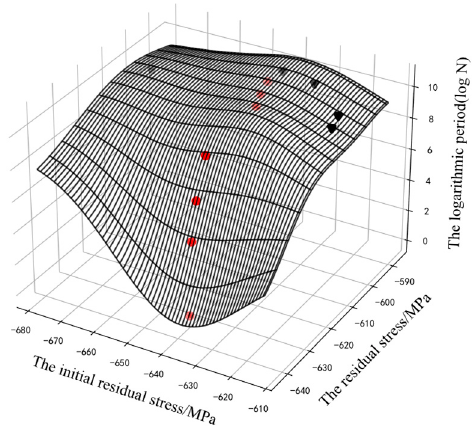
Figure 6. The assessment results of the GP: different line styles represent the fatigue relaxation process of different specimens. The triangle marks represent the data of specimens No. 2–6 and the circular mark represents the data of specimen No. 1.